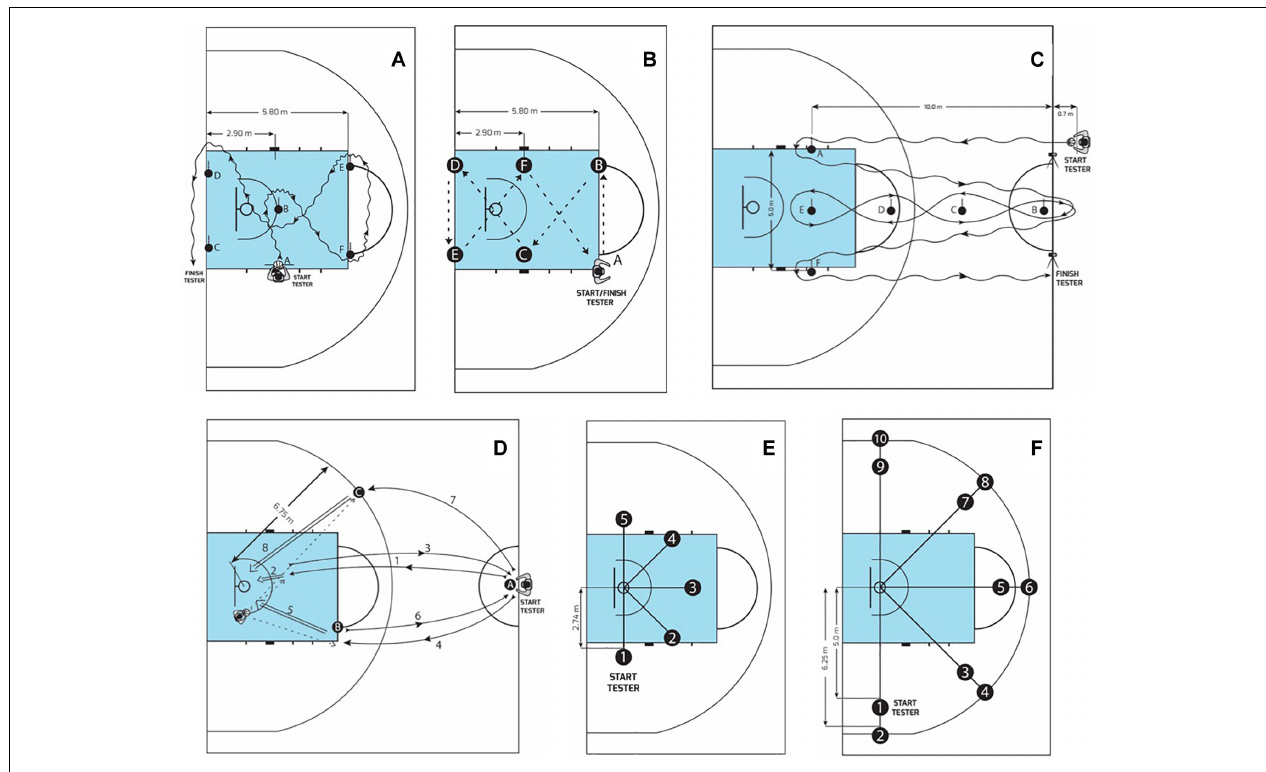
FIGURE 1 | Testing protocols used: (A) Control dribble test; (B) Defensive movement test; (C) Illinois test with dribbling the ball; (D) 1 min shooting test; (E) Modified medium and long range shots test; (F) Speed spot shooting test.